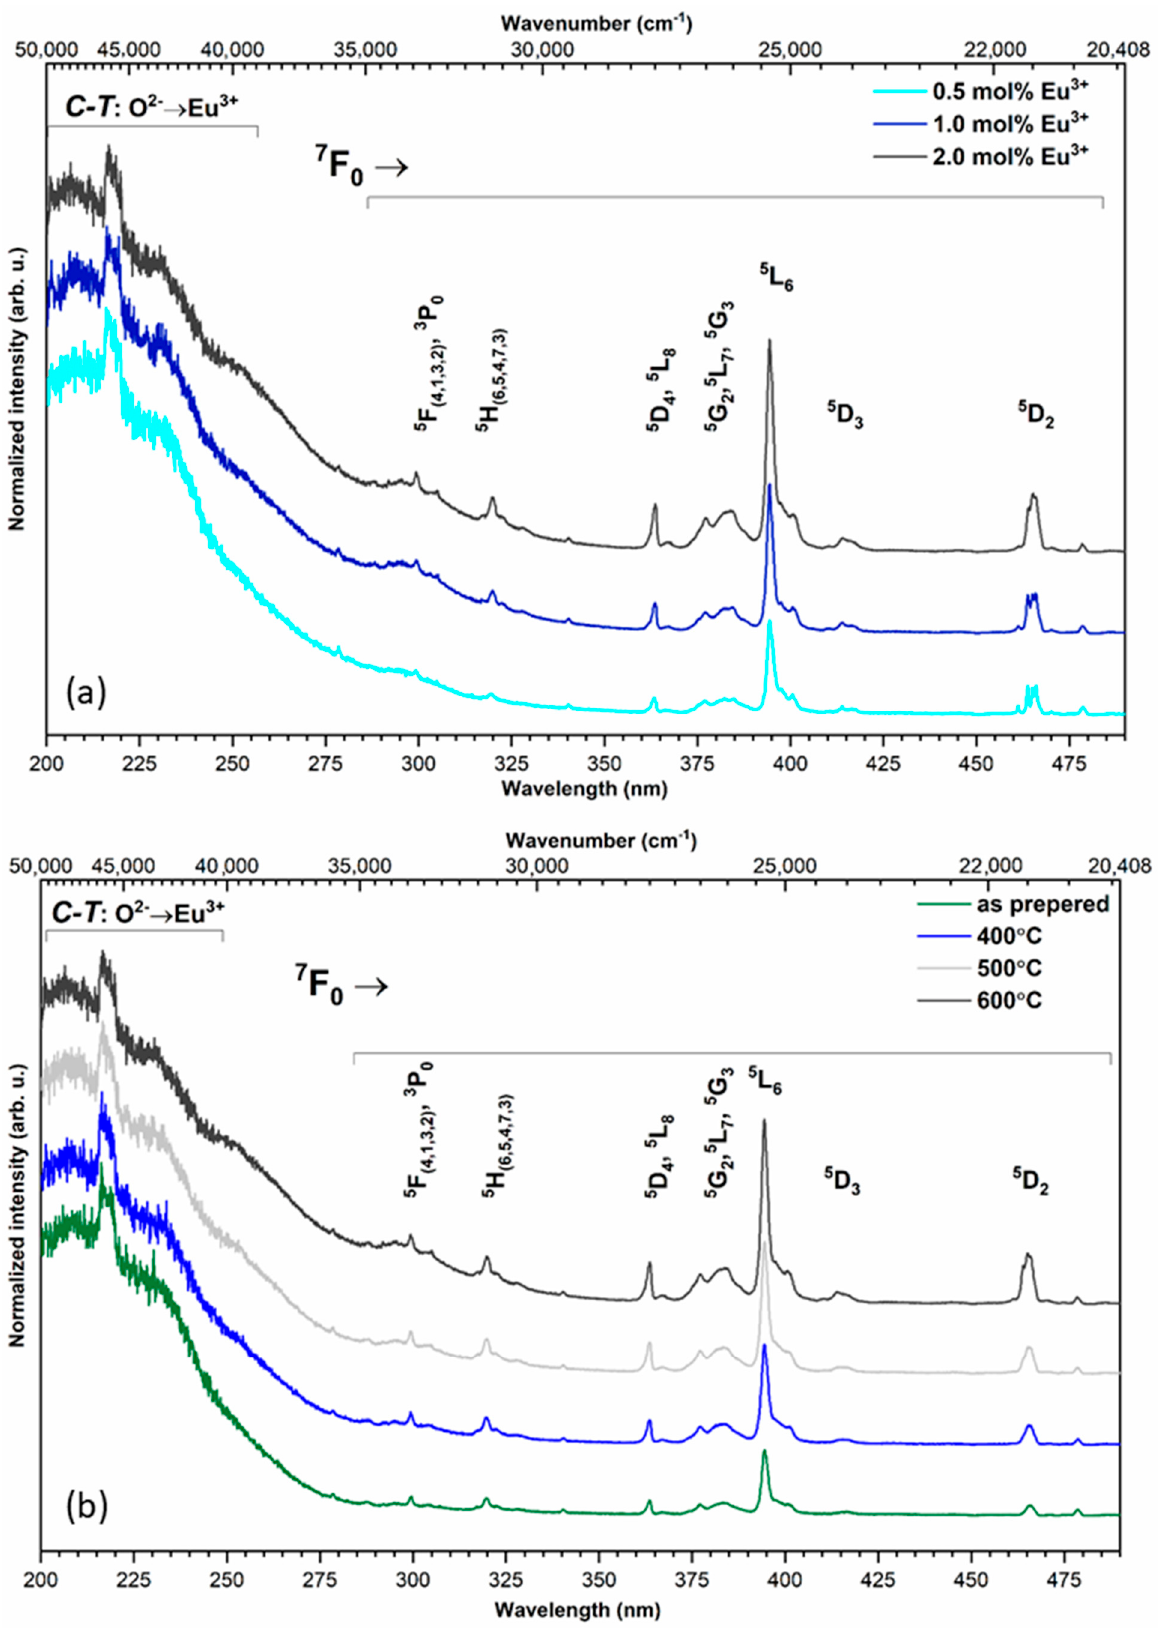
Figure 3. Excitation emission spectra of Ca 9.8-x Sr 0.2 Eu x (PO 4 ) 2 (SiO 4 ) 4 (OH) 2 , where x = 0.5, 1.0, 2.0 mol%, sintered at 600 °C ( a ) as well as Ca 9.6 Sr 0.2 Eu 0.2 (PO 4 ) 2 (SiO 4 ) 4 (OH) 2 as a function of sintering temperature ( b ).